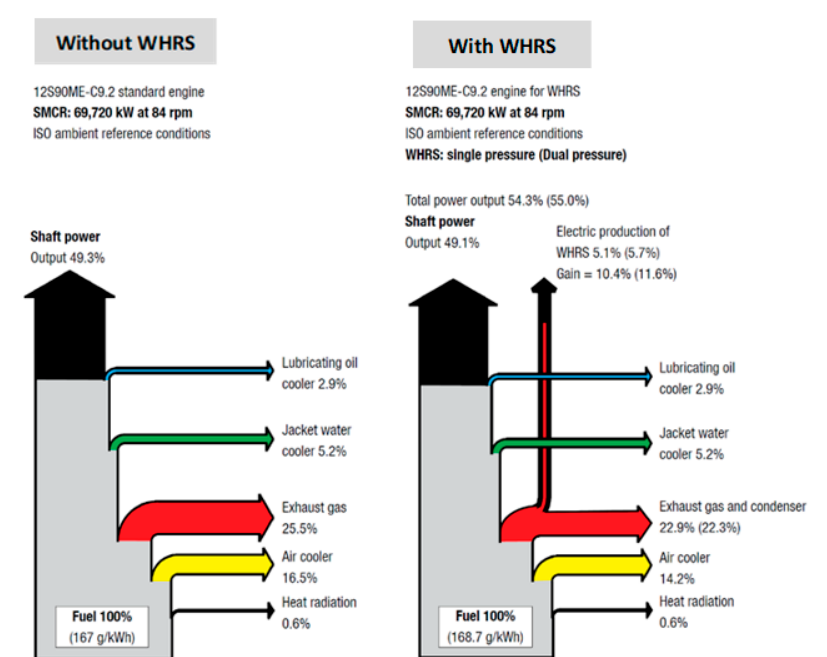
Figure 1. Energy equilibriums using the WHRS. Source: MAN [7].